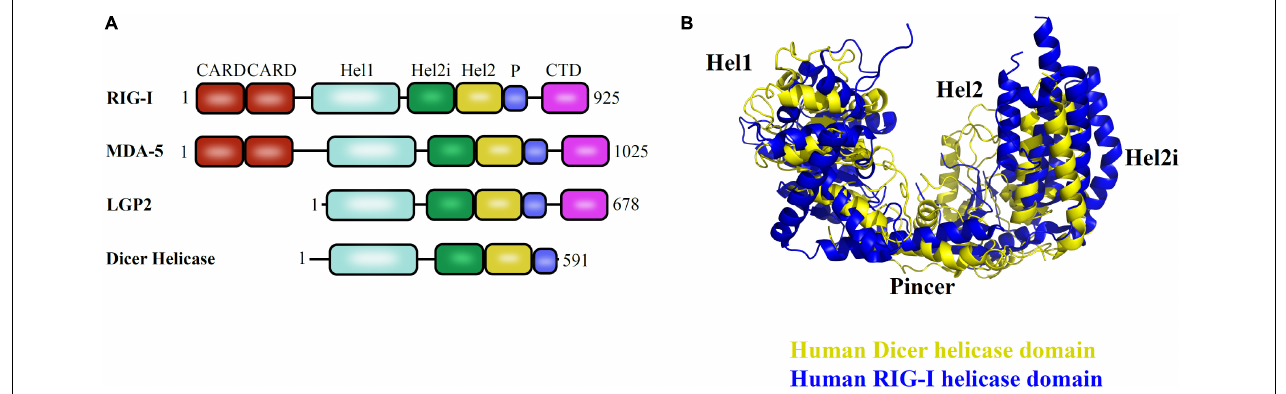
FIGURE 5 | Helicase domain of RLR family of proteins and Dicer in humans. (A) Conserved domain architecture of proteins functioning in different pathways. (B) Overlay of Hs Dcr helicase (PDB code: 5ZAL) and human RIG-I helicase domains (PDB code: 2YKG) suggests the overall conservation in the three-dimensional orientation of subdomains. The positioning of Hel2 and Hel2i subdomains around the Hel1 domain forms a groove that is essential for interaction with the terminal loop of pre-miRNA as shown in Hs Dcr and to mediate interaction with blunt dsRNA precursor as demonstrated in Dm Dcr-2 (Liu et al., 2018; Sinha et al., 2018).